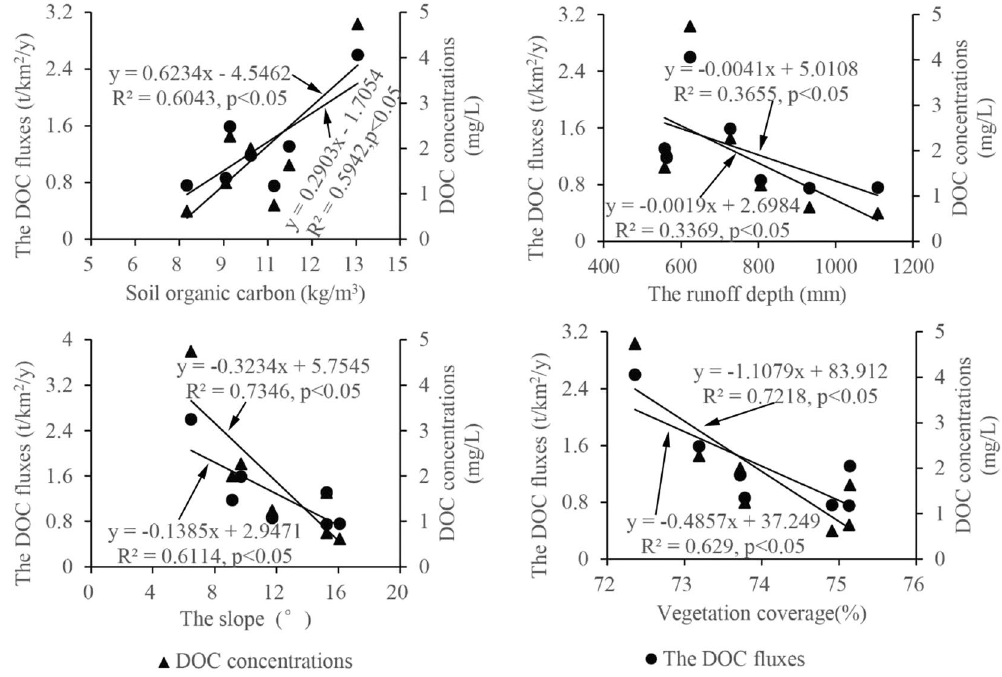
Figure 5. Influencing factors of organic carbon output in